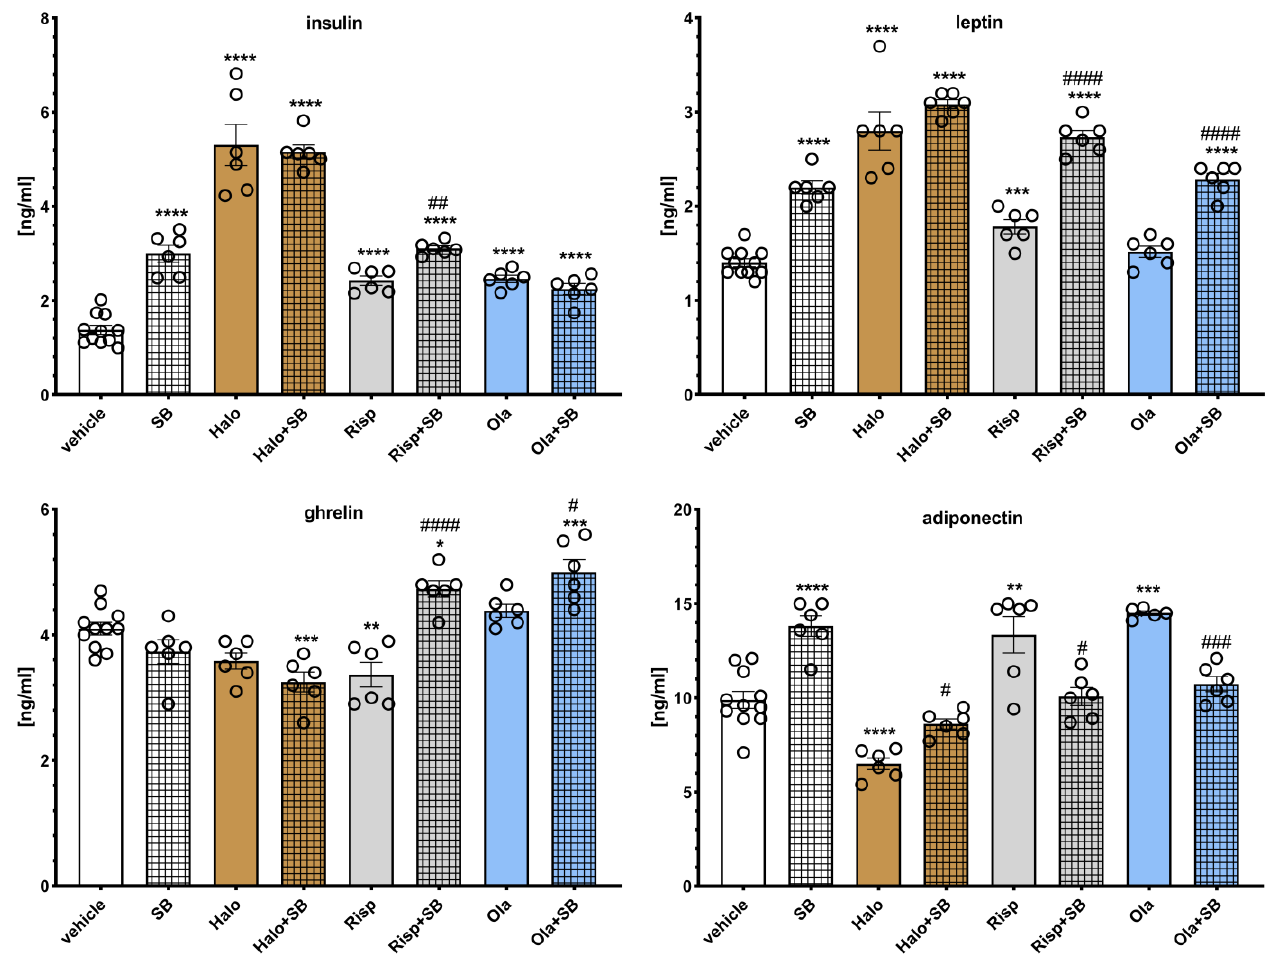
Figure 8. Effects of haloperidol, risperidone, olanzapine, and SB-742457, administered alone and in combinations, on the serum levels of insulin, ghrelin, leptin, and adiponectin in rats. The results are presented as mean ± SEM; n = 6–11. * p < 0.05, ** p < 0.01, *** p < 0.001, **** p < 0.0001 versus the respective vehicle-treated group; # p < 0.05, ## p < 0.01, ### p < 0.001, #### p < 0.0001 versus respective APD-treated group (two-way ANOVA followed by Bonferroni’s post hoc test). Halo, haloperidol 0.5 mg/kg; Risp, risperidone 0.5 mg/kg; Ola, olanzapine 5 mg/kg; SB, SB-742457 3 mg/kg.